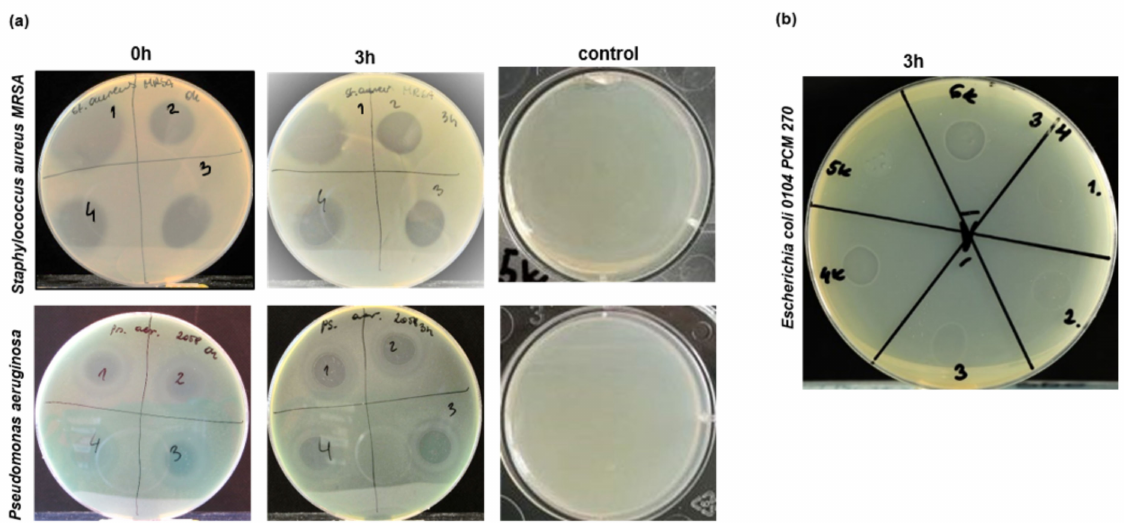
Figure 8. Antimicrobial activity of HATMSC supernatants. ( a ) Growth inhibition of S. aureus (top panel) and P. aeruginosa (bottom panel) following treatment with supernatants collected from human adipose tissue MSC cell lines: 1—HATMSC1, 2—HATMSC2, 3—HATMSC2D10 and HATMSC2F10. Supernatant samples were applied immediately following bacteria application on plates (0h) or three hours later (3 h). As a control, the DMEM medium without antibiotic used for supernatant production was applied; ( b ) Growth inhibition of E. coli following treatment of hydrogel loaded with HATMSC2 supernatant: 1—1:1 ( v / v ), 2—1:2 ( v / v ), 3—1:3 ( v / v ), and controls 4—supernatant only, 5—hydrogel only, 6—DMEM with supernatant 1:3 ( v / v